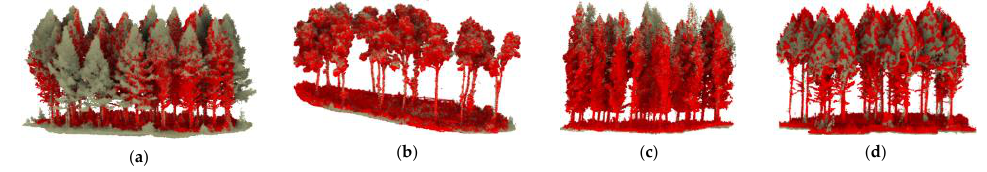
Figure 7. Registration results of the multiplatform point clouds. The gray points are the UAV data, and the red points are the TLS data. ( a – d ) represent the results of Dataset 1, 2, 3, and 4, respectively. In this study, the proposed adjustment framework performs well even if it has to solve a relatively large deviation between the UAV and TLS data. The UAV data are con- sistent with the TLS data in the four datasets, and there are few deviations in both the horizontal and vertical directions. In addition, we selected some corresponding feature points and computed the distance between the correspondences to quantitatively evaluate the registration accuracies in the horizontal and vertical directions (see Table 3 and Table 4, respectively). Table 3. Horizontal accuracy. The ‘Dataset’ column represents the dataset index. The ‘Features’ column gives the number NT of the detected points in each dataset. The deviation is calculated as the horizontal distance between the corresponding features from the TLS and UAV data. Dataset